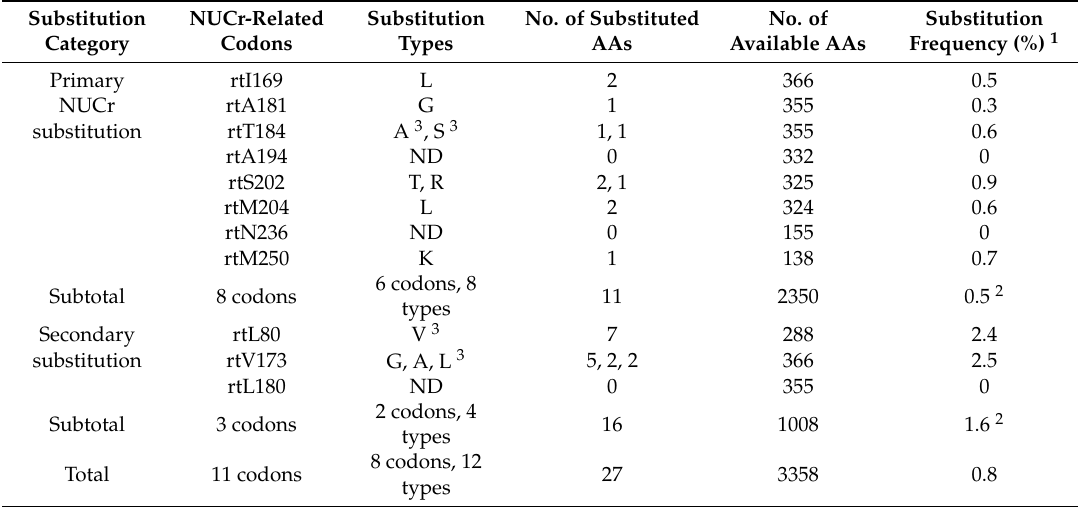
Table 2. The AA substitutions identified at the primary NUCr and secondary substitution codons in RT-containing